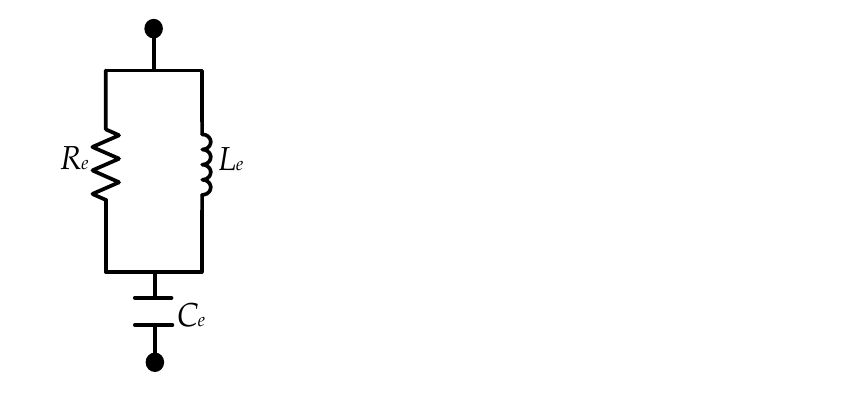
Figure 6. The optimized fractional-order electrical network structure. Table 3. Optimization parameters. Fractional-Order ISD